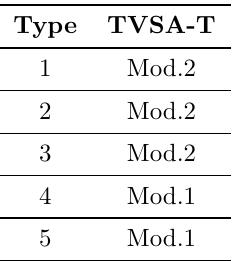
Table 2. Types of spacing grids.